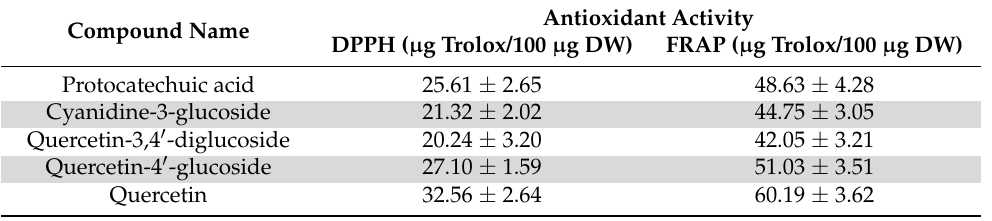
Table 3. Antioxidant capacity of the main compounds of red onion extract.